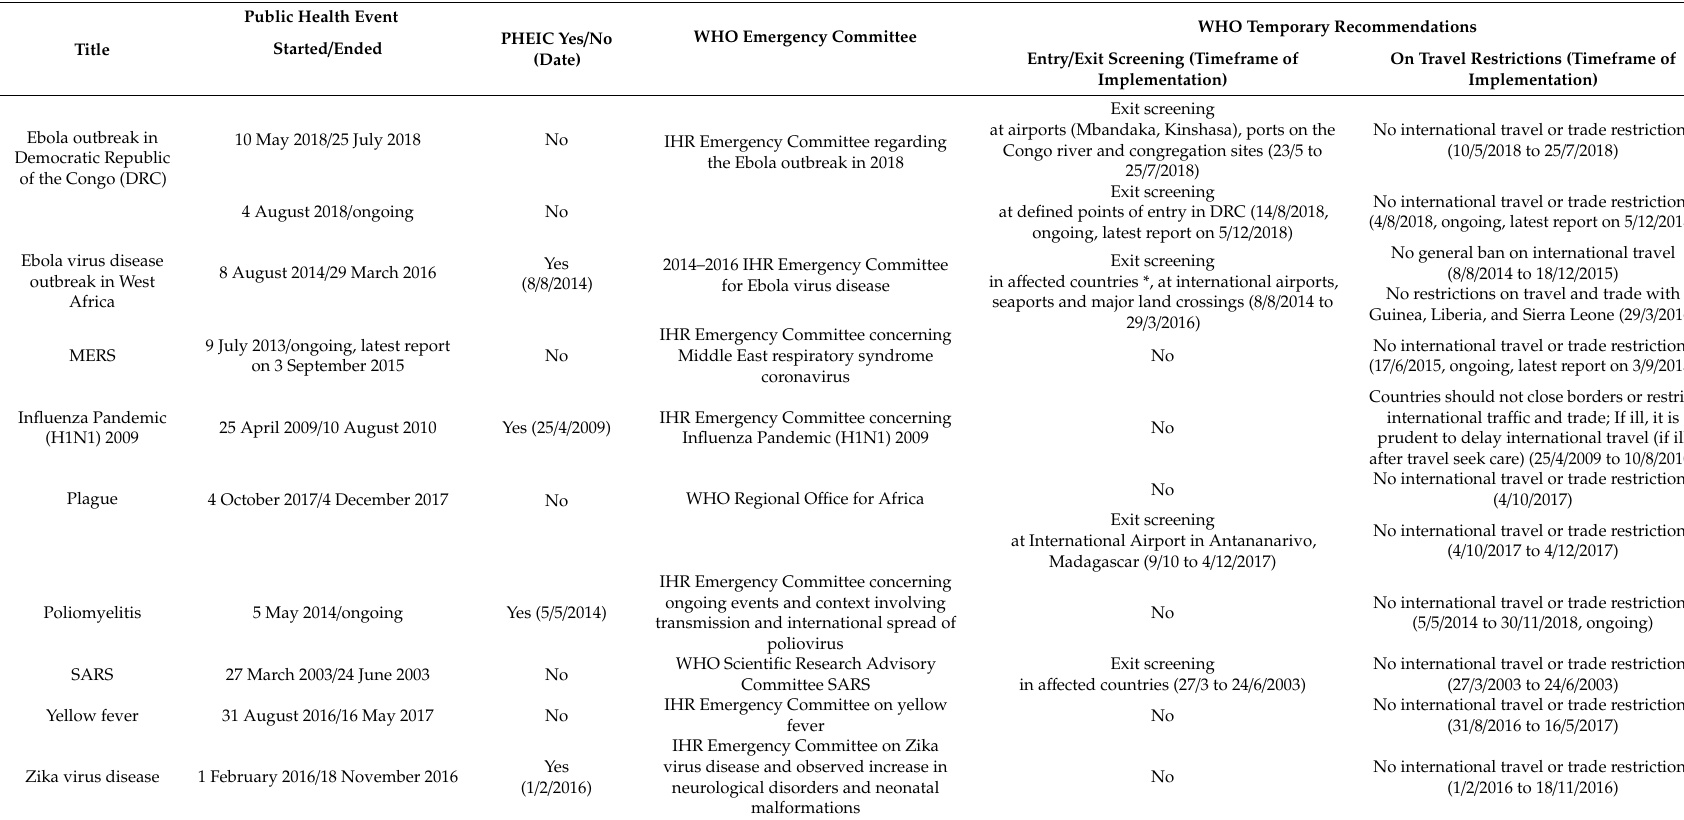
Table 5. WHO temporary recommendations for entry and exit screening at points of entry (data in the table were extracted from the reports available from the WHO IHR (see Appendix